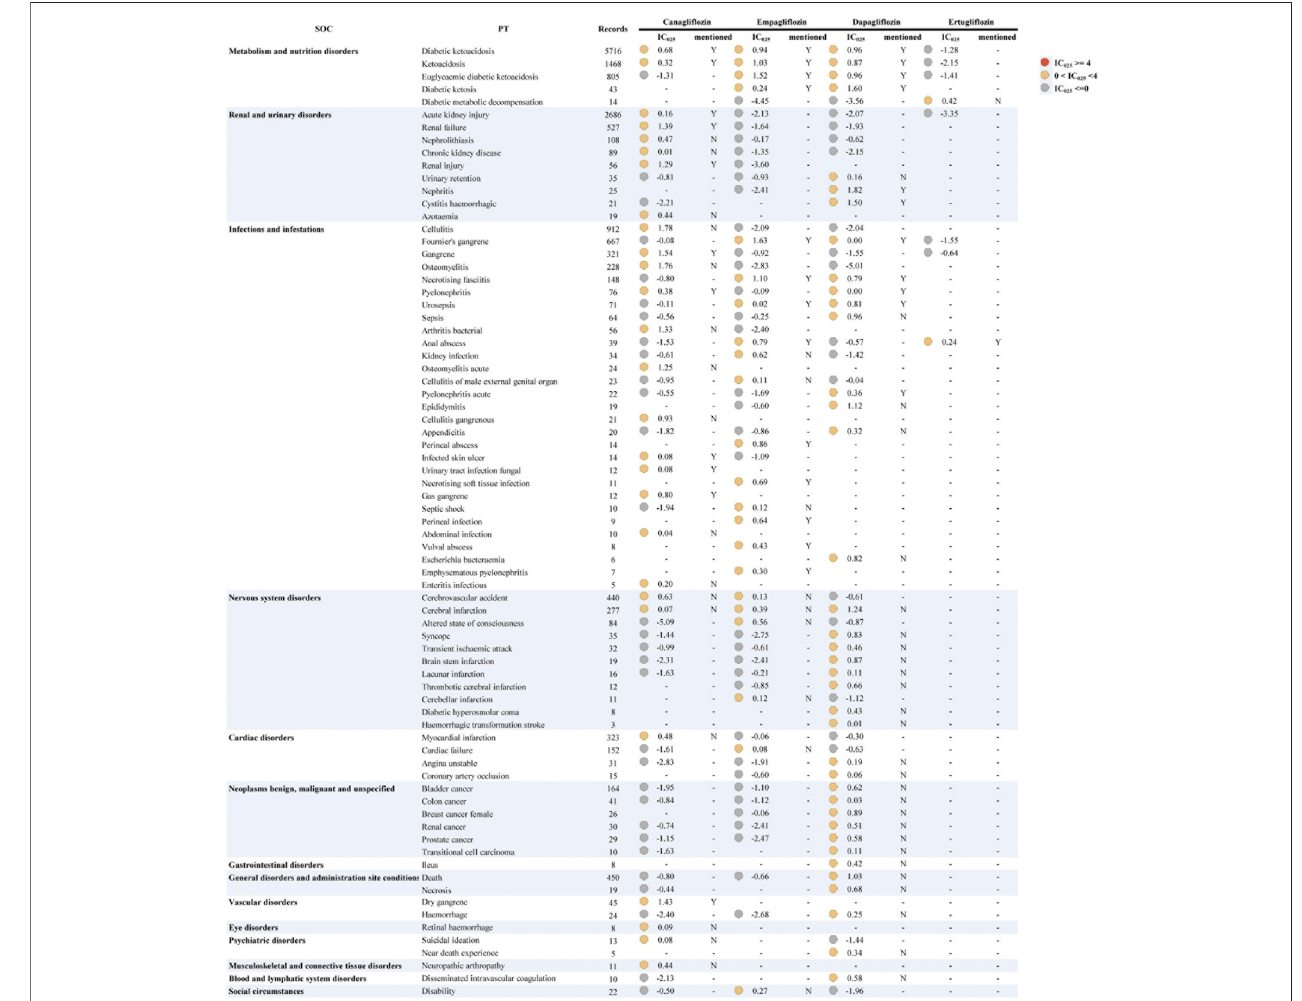
FIGURE 2 | Signal pro fi les of all IMEs induced by SGLT2i monotherapy-based on other antidiabetic drugs as “ non-case ” * *In Figure 2 , IMEs, Important Medical Events; SOC, System Organ Class; PT, Preferred Term; IC, information component; IC 025 , the lower limit of the 95% con fi dence interval of IC. IC 025 greater than 0 was deemed a signal. IC 025 no less than 4 was deemed a strong